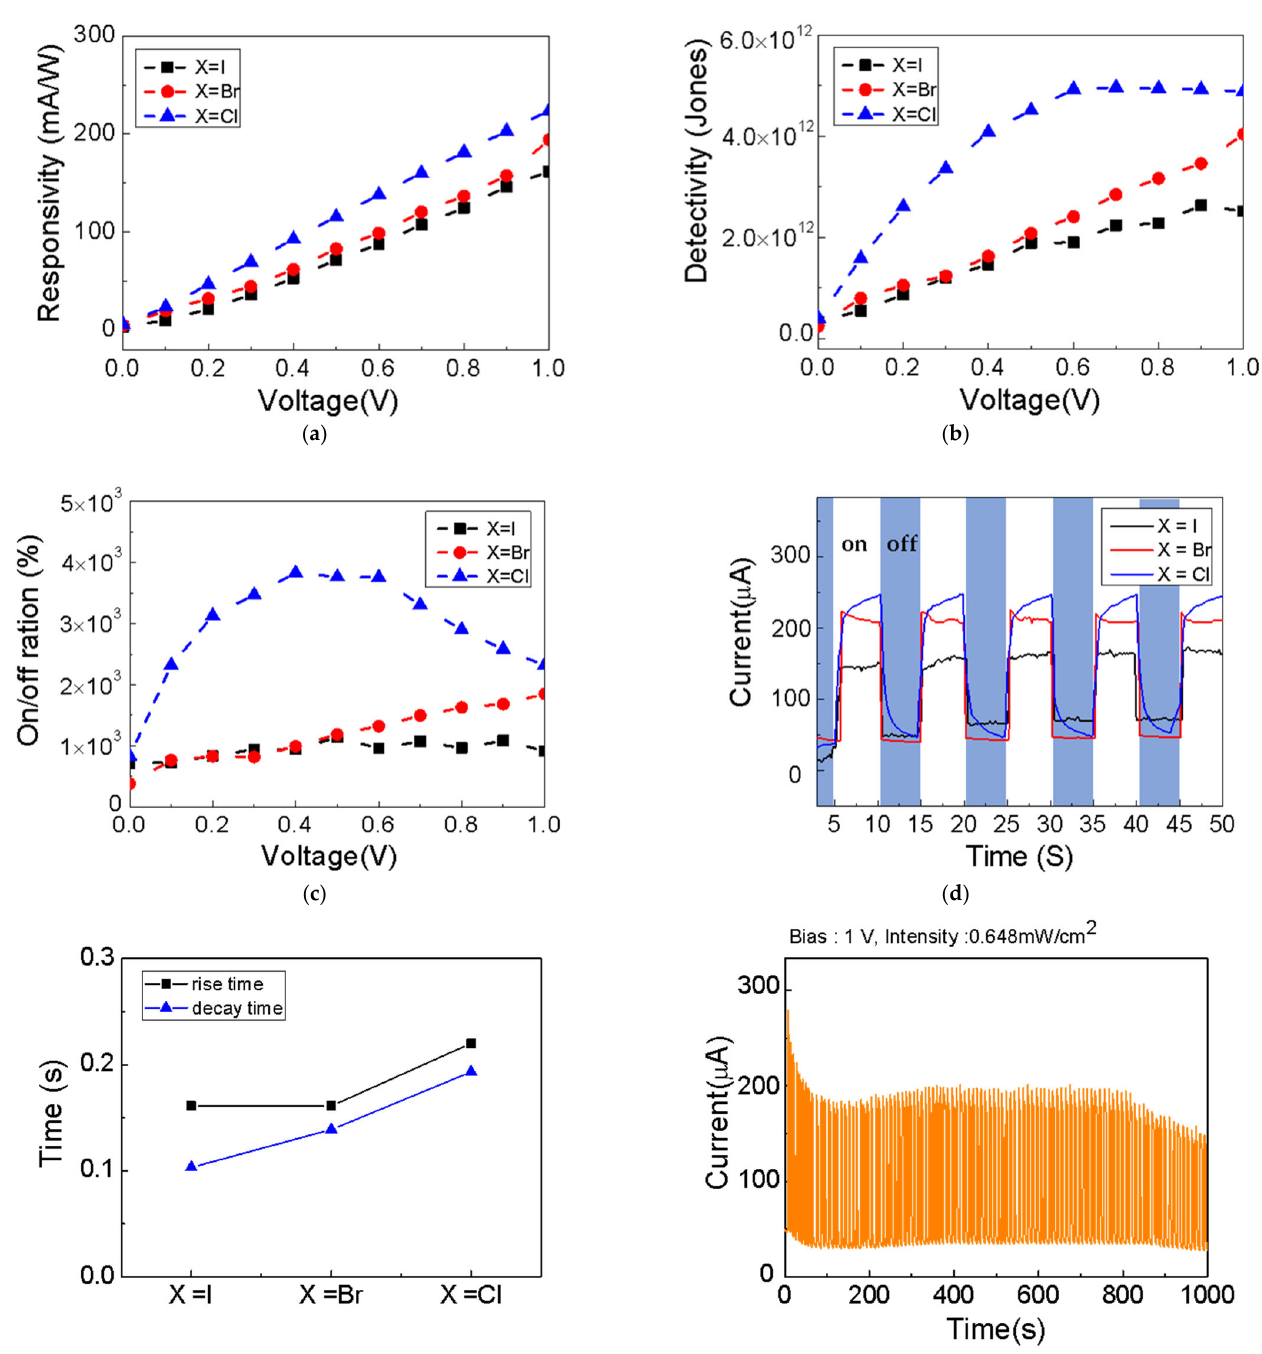
Figure 7. Responses of the FAPbX 3 ‐ MAPbX 3 (X = I, Br, and Cl) detectors: ( a ) responsivity; ( b ) detectivity; ( c ) on/off ratio; ( d ) transient photoresponse through repeated on/off cycles ; ( e ) detector response time, rise ‐ time, and decay ‐ time; and ( f ) switching of detectors to investigate photostability.